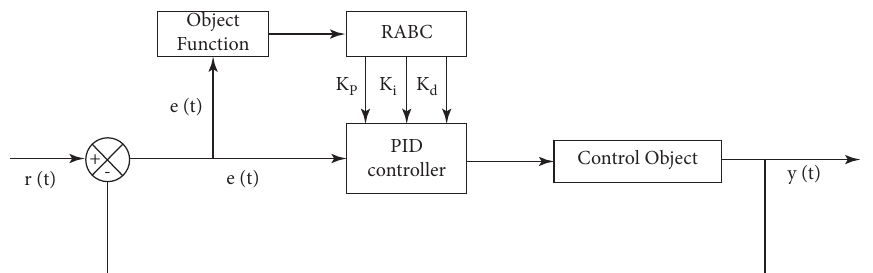
Figure 2: PID parameter tuning block diagram of reformative artificial bee colony